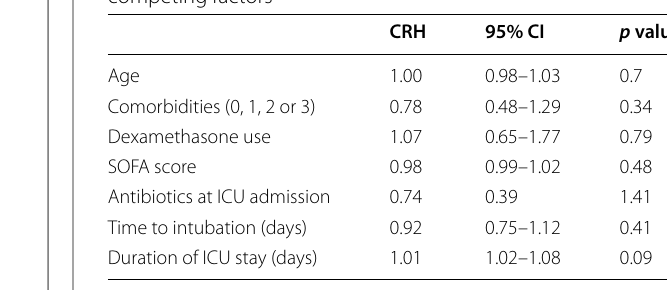
Table 3 Multivariate analysis of the factors associated with